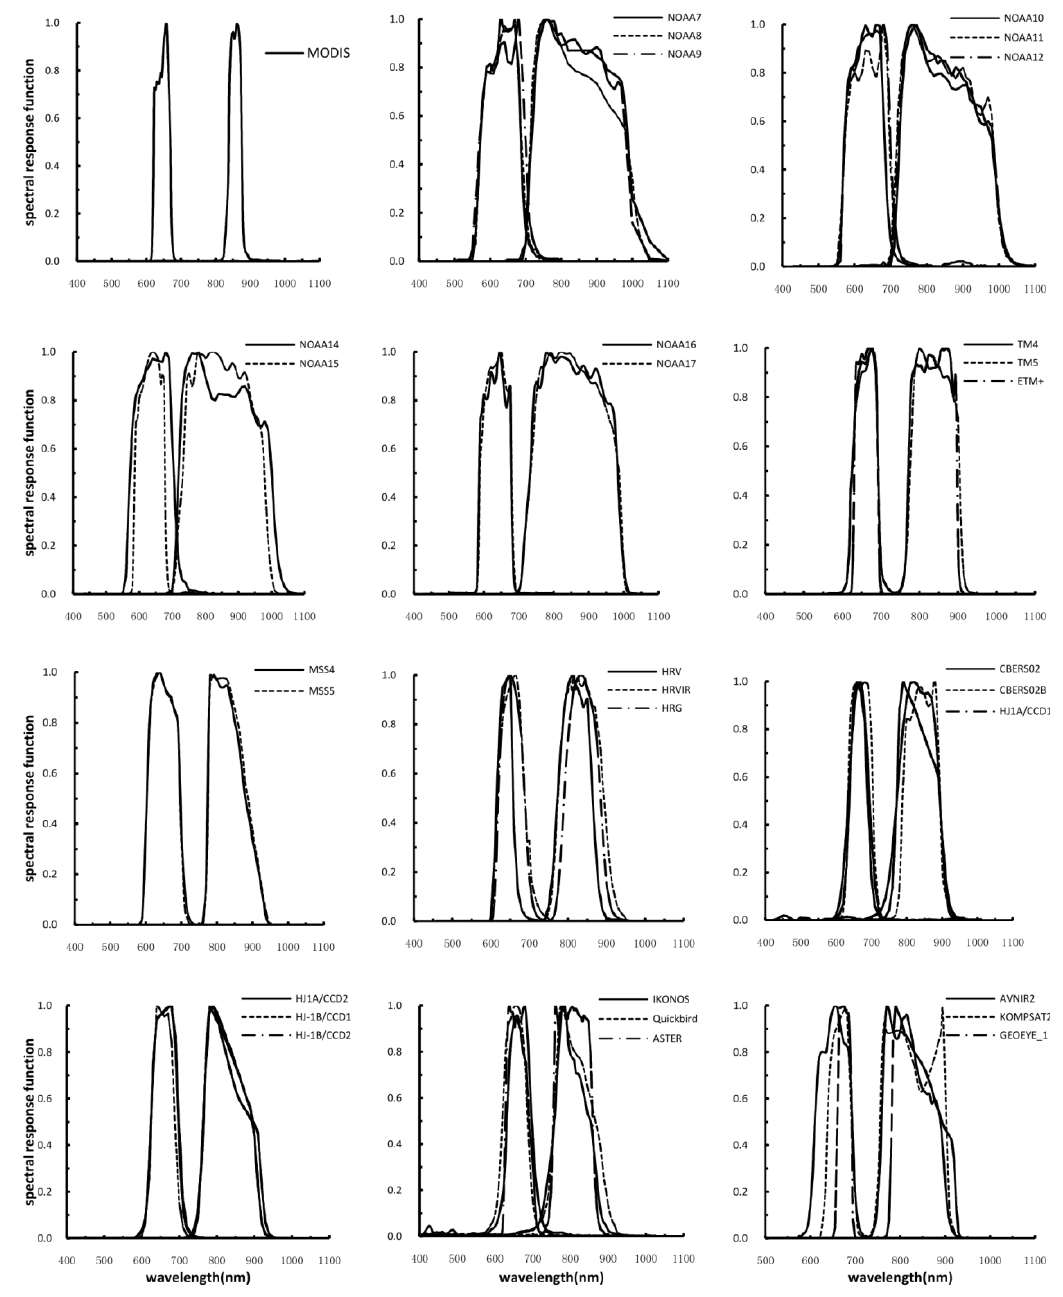
Figure 4. Relative spectral response functions of the red and NIR channels for the sensor systems simulated in this